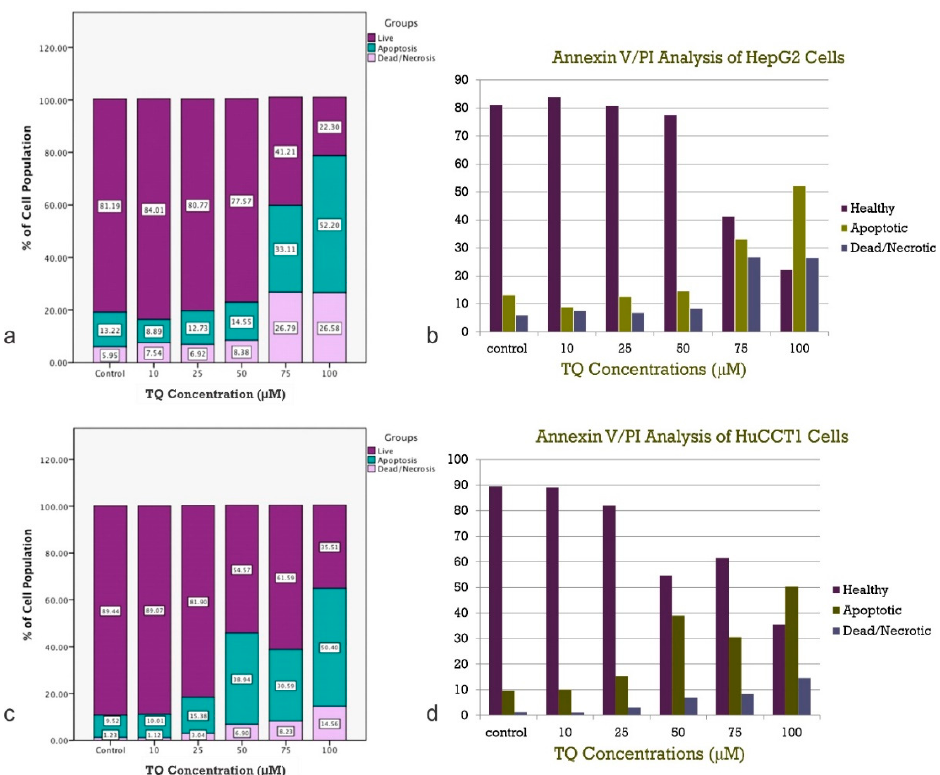
Figure 6. ( a , b ) Flow cytometric Analysis of FITC using Annexin V/PI staining of HepG2 cell lines (see text for details). ( c , d ) Flow cytometric Analysis of FITC using Annexin V/PI staining of HuCCT1 cell lines (see text for details).